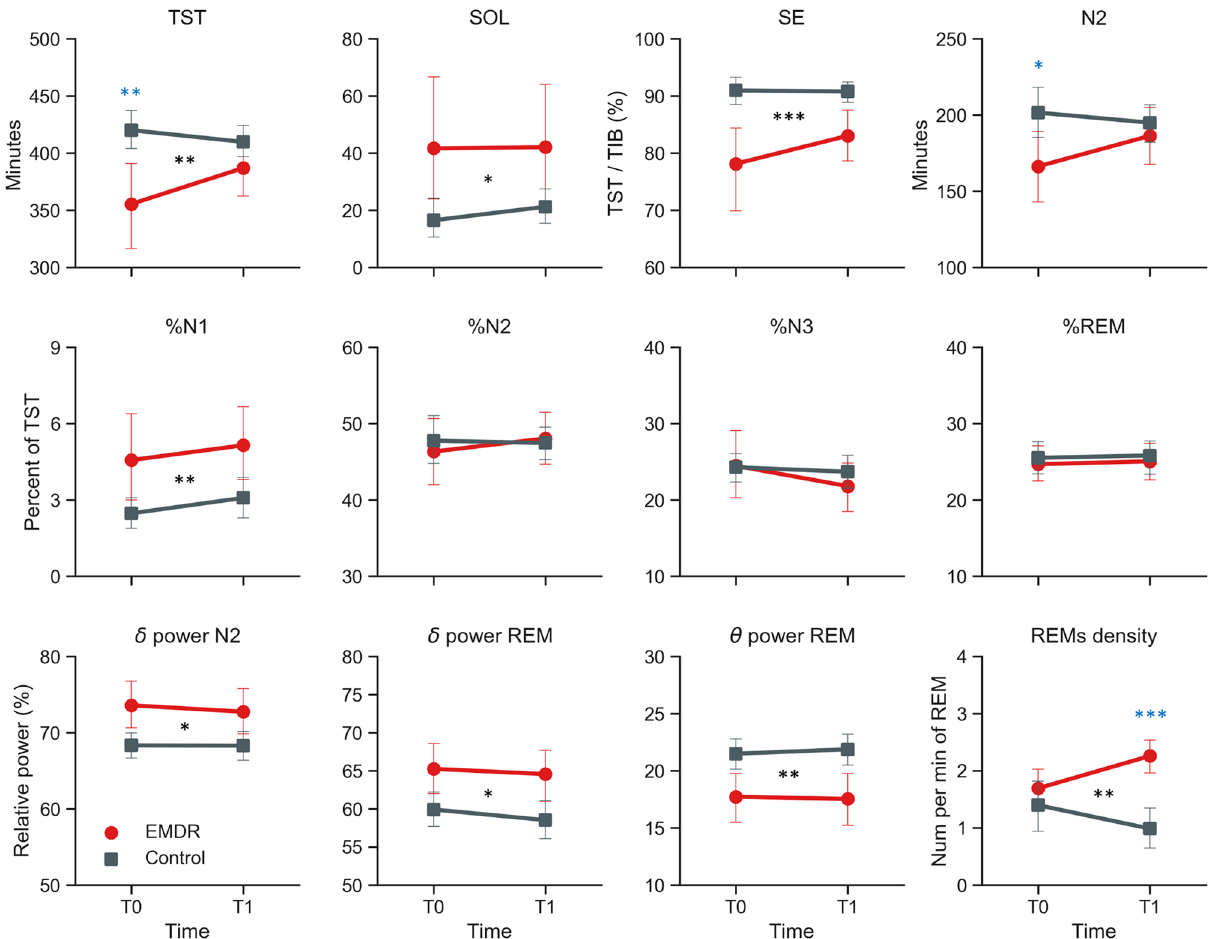
Figure 1. Sleep parameters. Red lines = EMDR group, grey lines = control group. Black stars indicate significant group main effects, while blue stars represent significant post-hoc tests when a significant interaction group × time was present. F-values are reported in Table 2. *p < 0.05, **p < 0.01, ***p < 0.001. TST total sleep time, SOL sleep onset latency, SE sleep